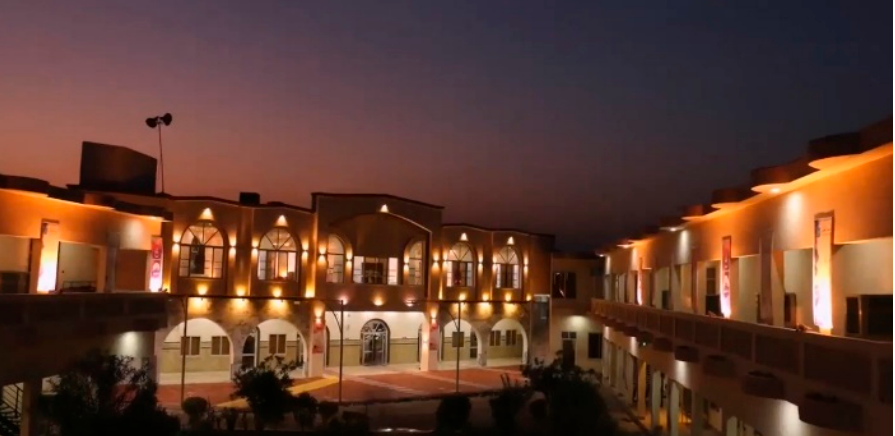
Figure 7. Maulana Tariq Jamil’s primary Dar al-Uloom institution, the Jamia al-Hasanain established